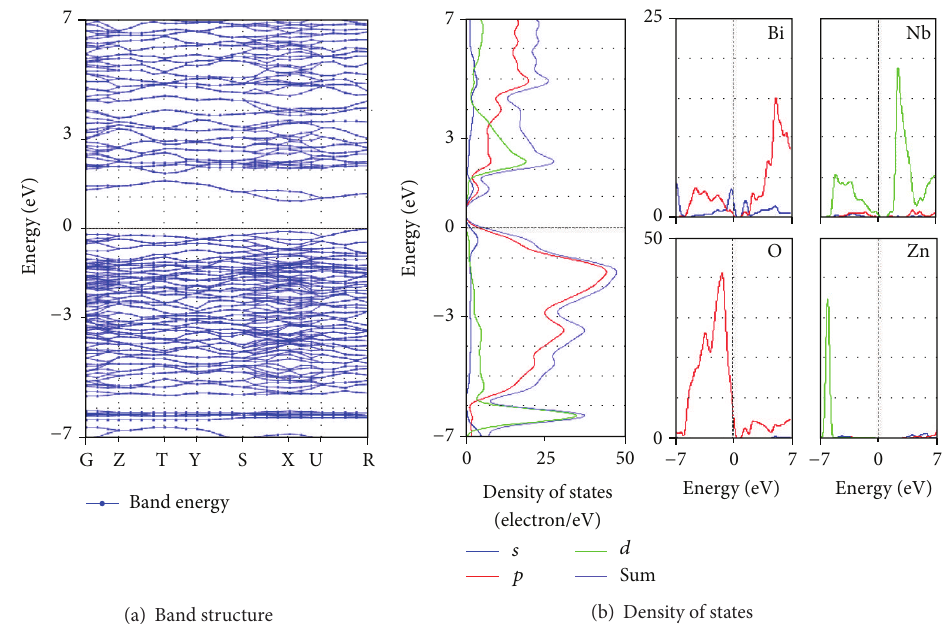
Figure 9: The band structure and DOS for the orthorhombic BZN partially ordered solid solution.